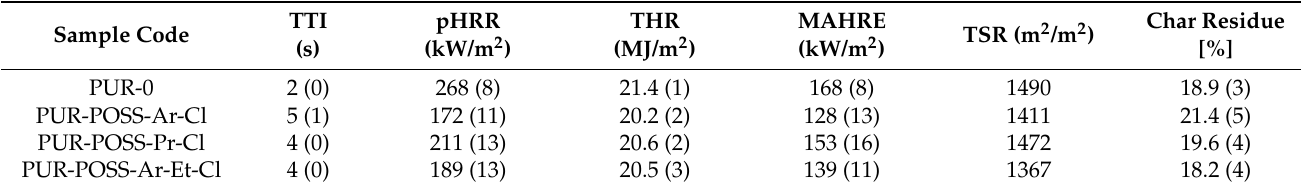
Table 4. Results of fire behavior of PUR foams modified with POSS-Cl.